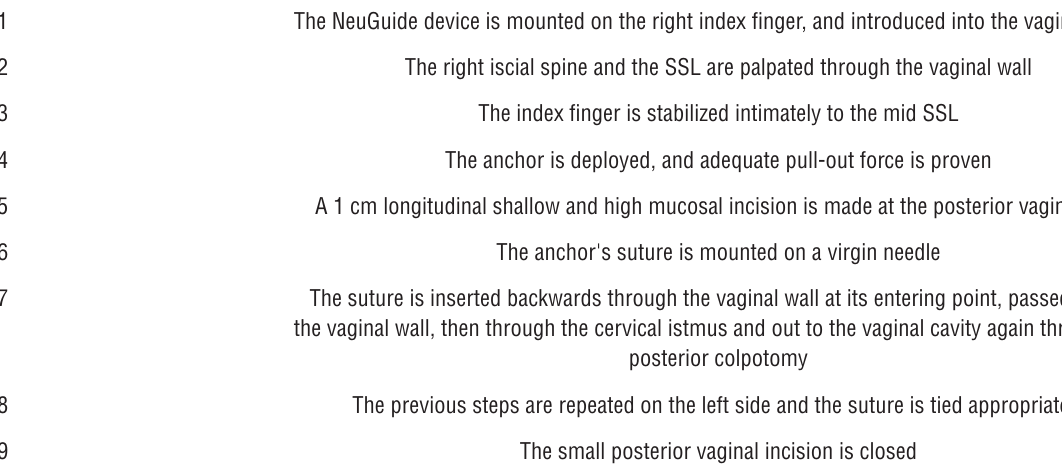
Table 1 - The steps of the neuGuide device surgical procedure.